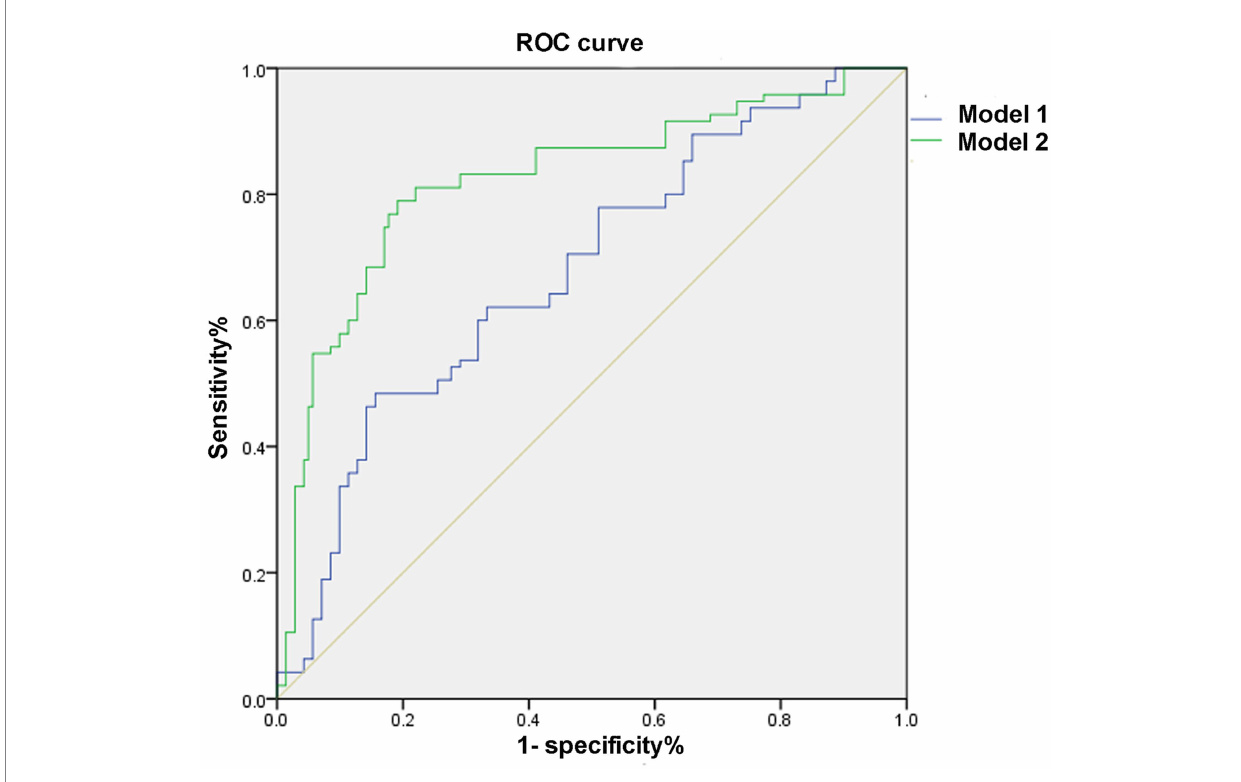
FIGURE 3 Receiver operating characteristic curve. Model 1: adjusted for age, systolic blood pressure, NIHSS score, and TOAST classification. Model 2: Model 1 plus nTreg/mTreg ratio. ROC, receiver operating characteristic curve; nTreg, naïve regulatory T cells; mTreg, memory regulatory T